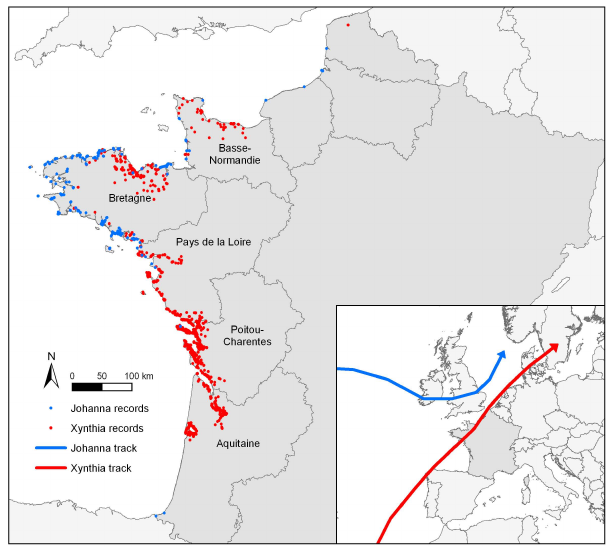
Fig. 1. Map of flood-damage records in the first-level database for the three insurance companies that took part in the study. The re- sulting dataset is believed to represent around 25% of the overall insurance market in